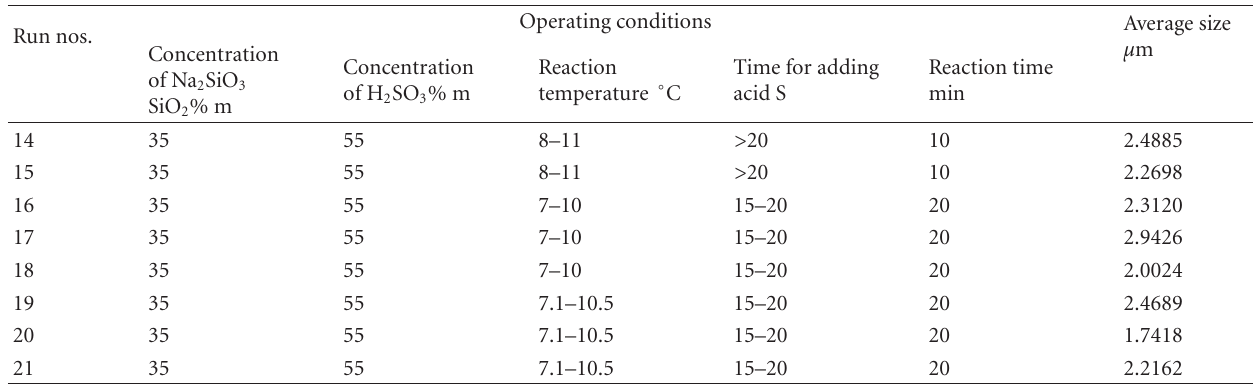
Table 7: Average sizes of products from a part of runs.